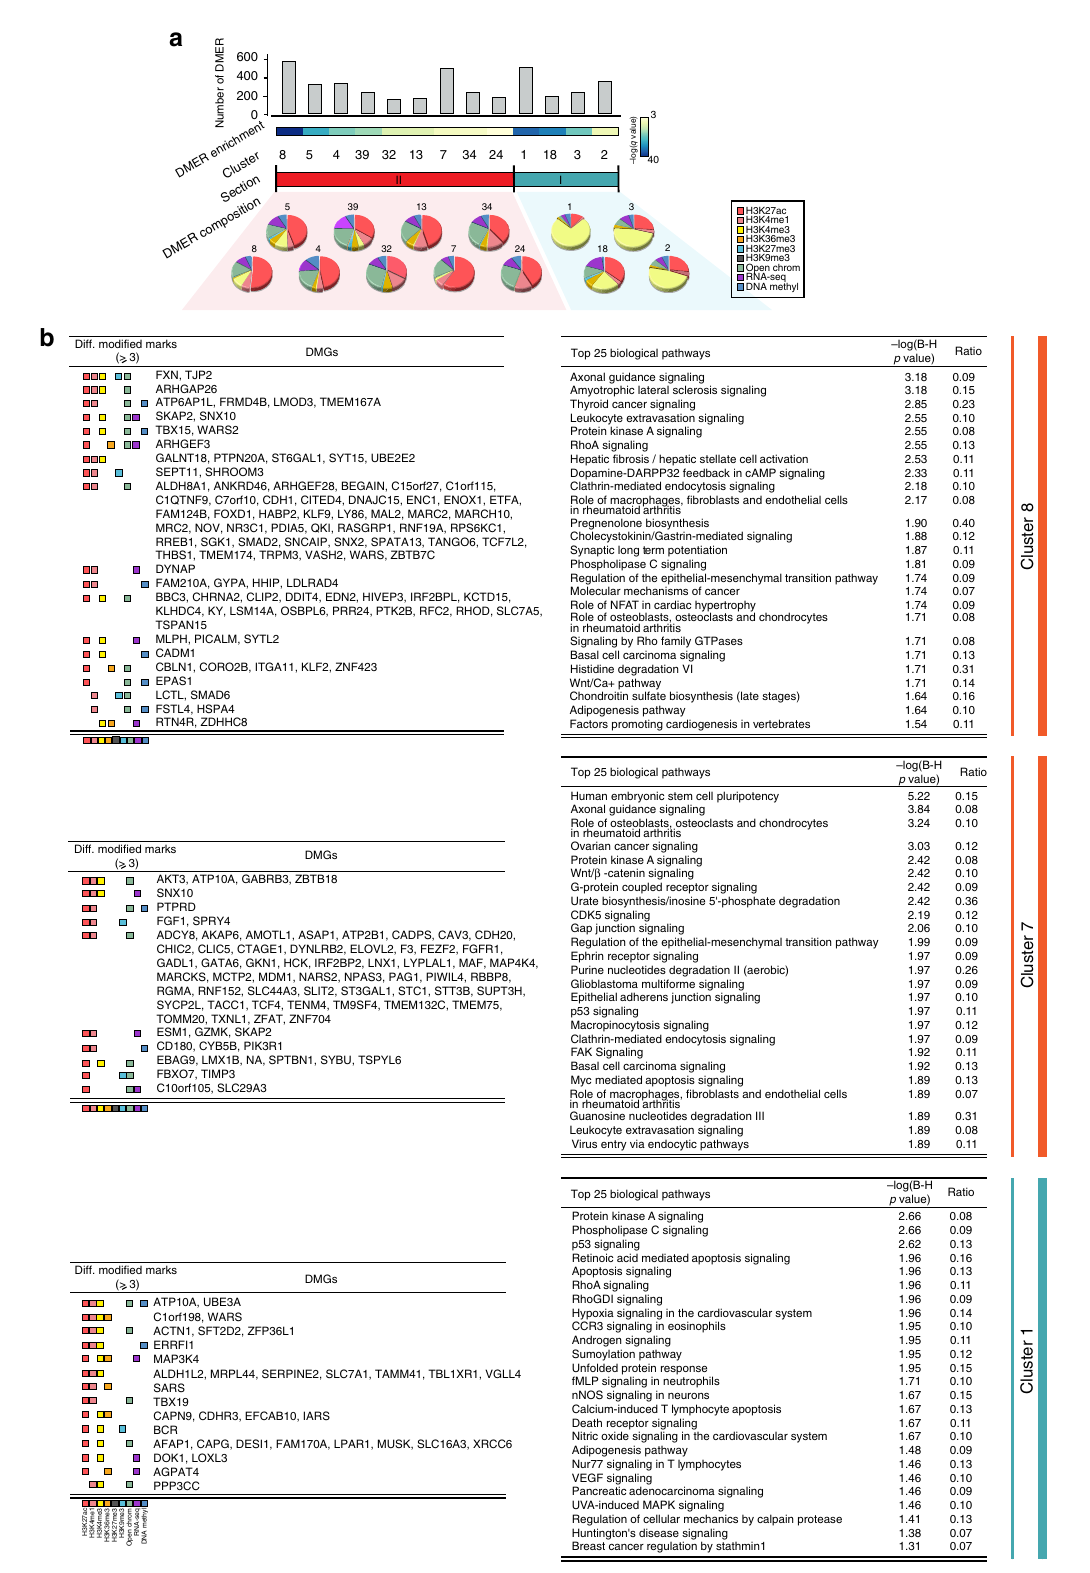
Fig. 3 Integrative analysis identi fi ed 13 clusters with signi fi cantly enriched DMERs. a The 13 enriched clusters are shown with the number of DMERs in each cluster. Below, the relative abundance of various types of differential marks is shown and demonstrates the high abundance of active enhancer and active promoter marks (section I and II). Nine clusters are associated with active enhancers and four with active promoters. b Characterization of three clusters with the most DMERs (1, 7, and 8). Top DMGs (left) and top enriched biological pathways associated with these genes (right) are